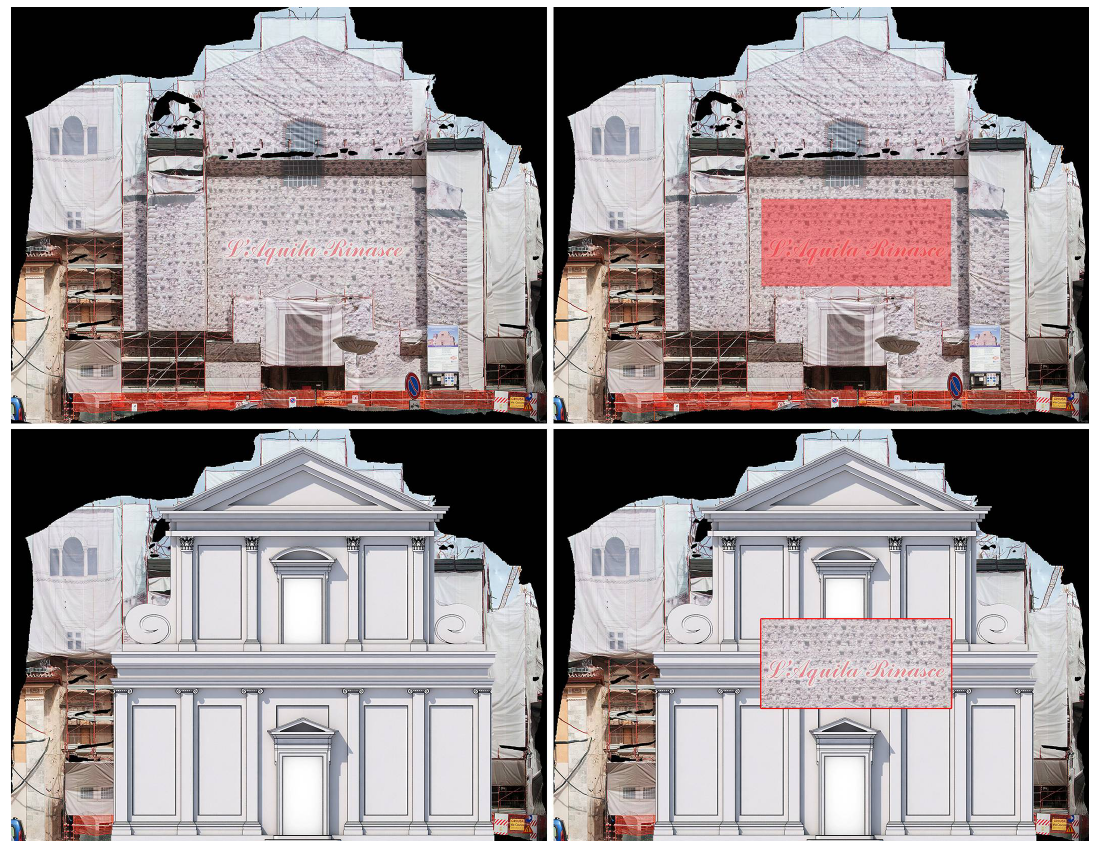
Figure 5. Some steps for Augmented Reality experimentation. The starting point is an orthophoto obtained by photogrammetry; an image portion was extracted to be used as target for the AR